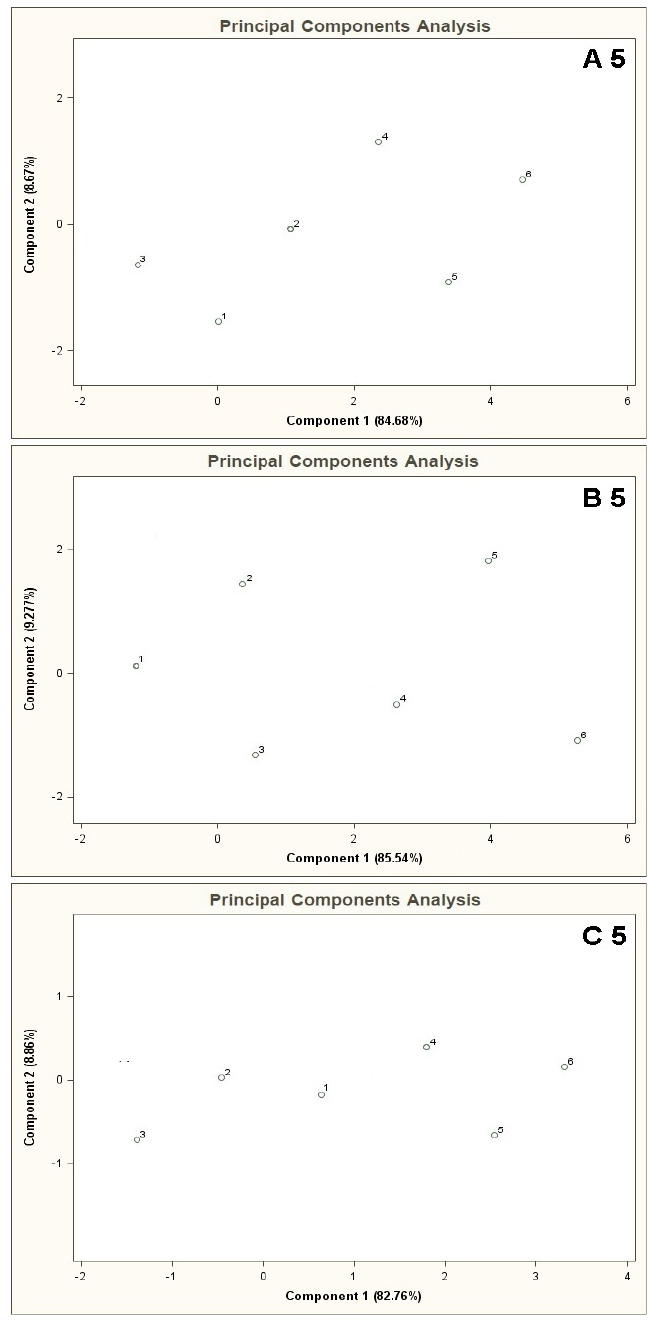
Figure 11. Result of PCA for the mixtures of type A 5 , B 5 , C 5 . Measurement was obtained for time instant 20